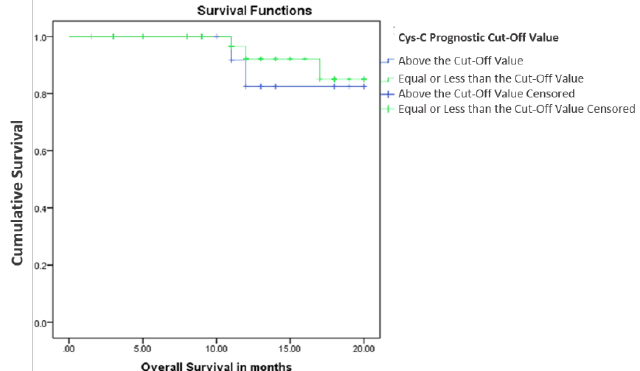
Figure 4. Overall survival according to the serum cystatin C prognostic cut-off value. Cum Survival: cumulative survival.